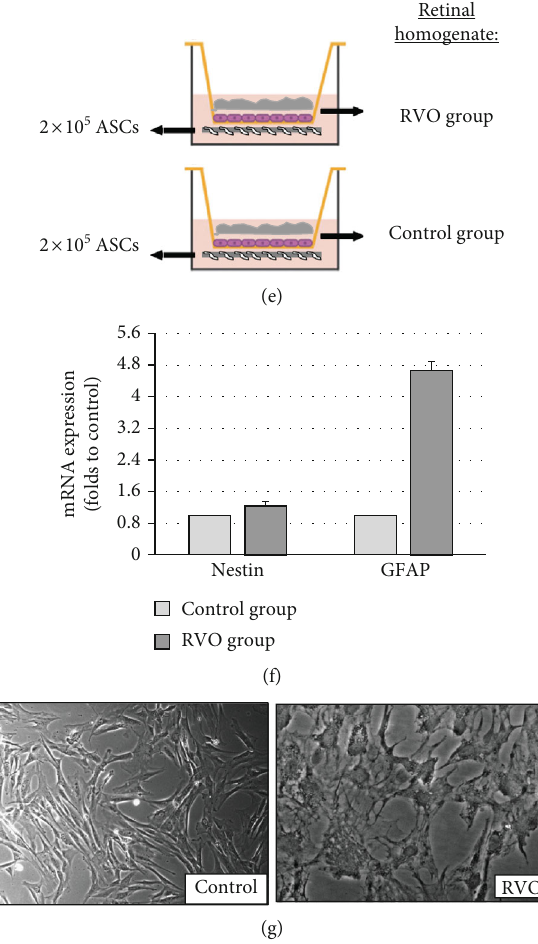
Figure 1: Detection of administered GFP+ ASCs in dissociated retina tissues and in vitro di ff erentiation capacity of ASCs towards neural cells as a response to speci fi c tissue stimuli in culture. (a) The muscles and connective tissues of the rabbit eyes were removed from the eye ball; the anterior segments of the eye including the cornea, iris, and lens were carefully removed. Then, the eye cup was used for retina isolation after sclera removal. Vitreous fl uid is collected with a syringe. (b) Flow cytometry histogram presents the expression of GFP signal from retina cell suspension in comparison with vitreous fl uid cell content. (c) Percentage of GFP+ cells in retina cell suspension and vitreous fl uid. (d) Detection of GFAP+/GFP+ ASCs in retina cell suspension of the ASC + NP group. Data are expressed as the mean ± SD ( ∗∗ P < 0 : 01 vs. RVO; n = 4 ). (e) Depiction of transwell culture systems with two types of retina homogenates. (f) Quanti fi cation of the transcriptional expression on neural markers NESTIN and GFAP in ASCs after culture in the presence of retina homogenates. (g) Morphological observation of ASCs after coculture with control (left) and RVO (right) tissue, respectively. Data are expressed as the mean ± SD ( n = 2